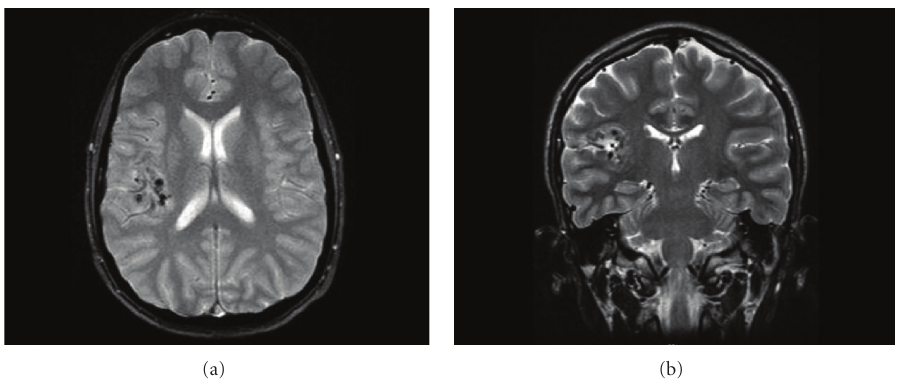
Figure 1: T2-weighted axial (a) and coronal (b) MRI performed 1 year prior to surgery show right posterior frontal flow void with adjacent cortical foci of susceptibility artifact suggesting vascular malformation.